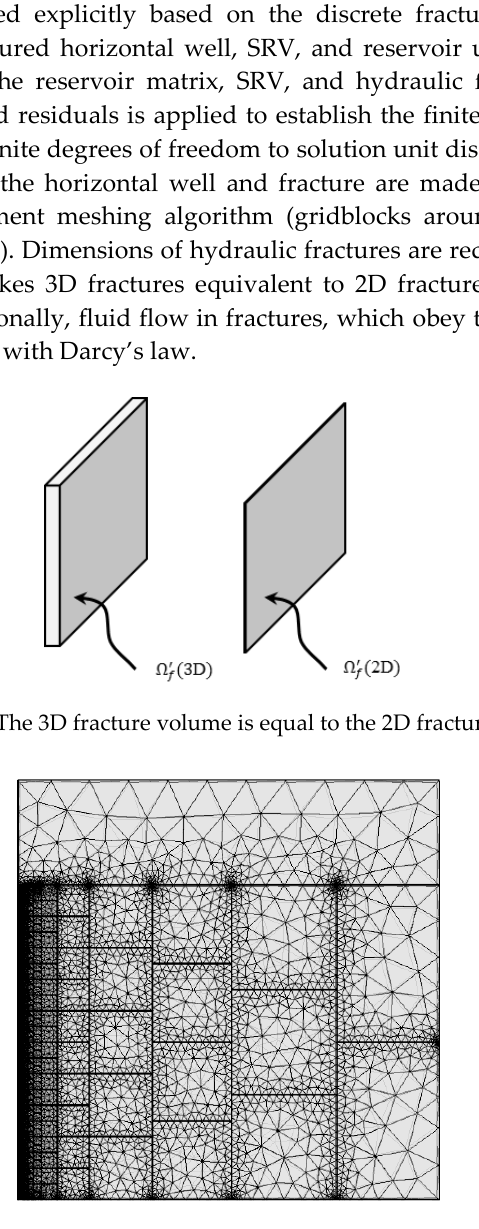
Figure A2. Grid meshing generated for FDFN